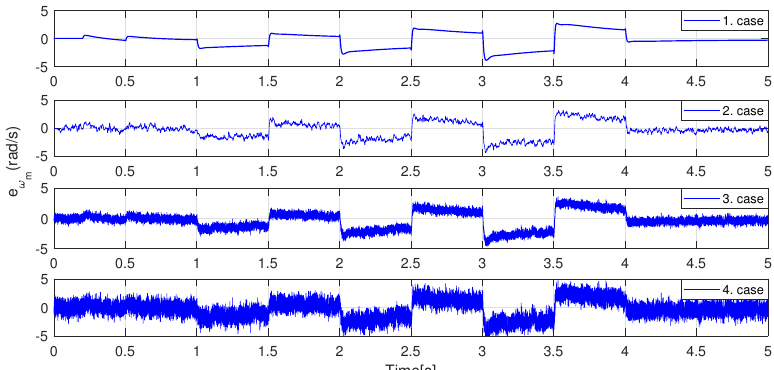
Figure 14. Speed controller error comparison for the parameter uncertainty